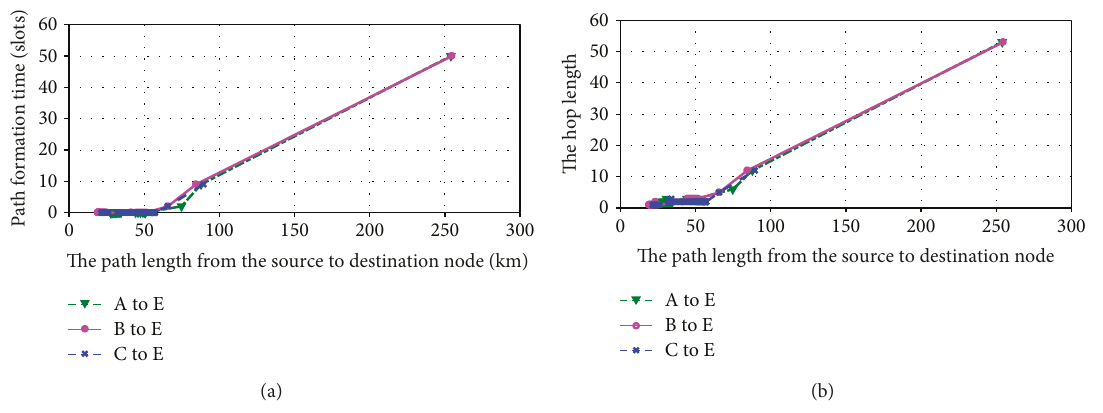
Figure 12: (a) The relationship between path formation time and path length. (b) The relationship between hop length and path length for di ff erent source-destination in the 25th orbit hyperperiod.